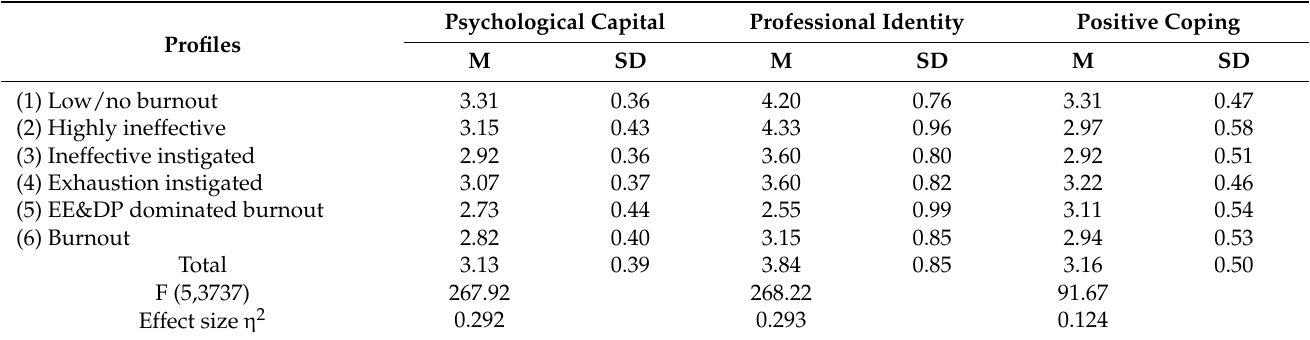
Table 4. Means and standard deviations of resource factors in each profile at T1.